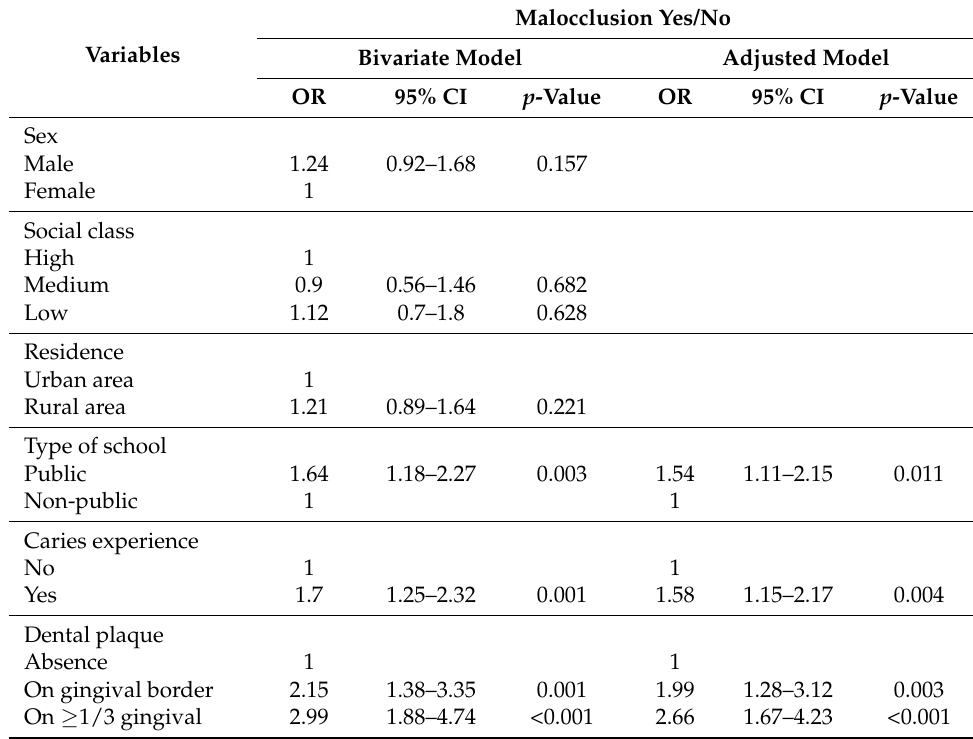
Table 5. Malocclusion risk in 12-year-old schoolchildren using bivariate and multivariate logistic regression